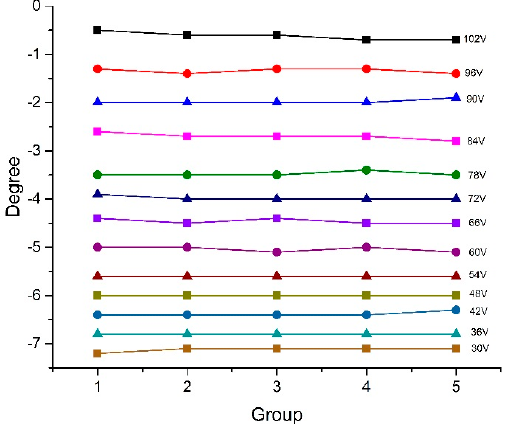
Figure 12. The temperature insensitive response of phase difference at each controlling voltage.